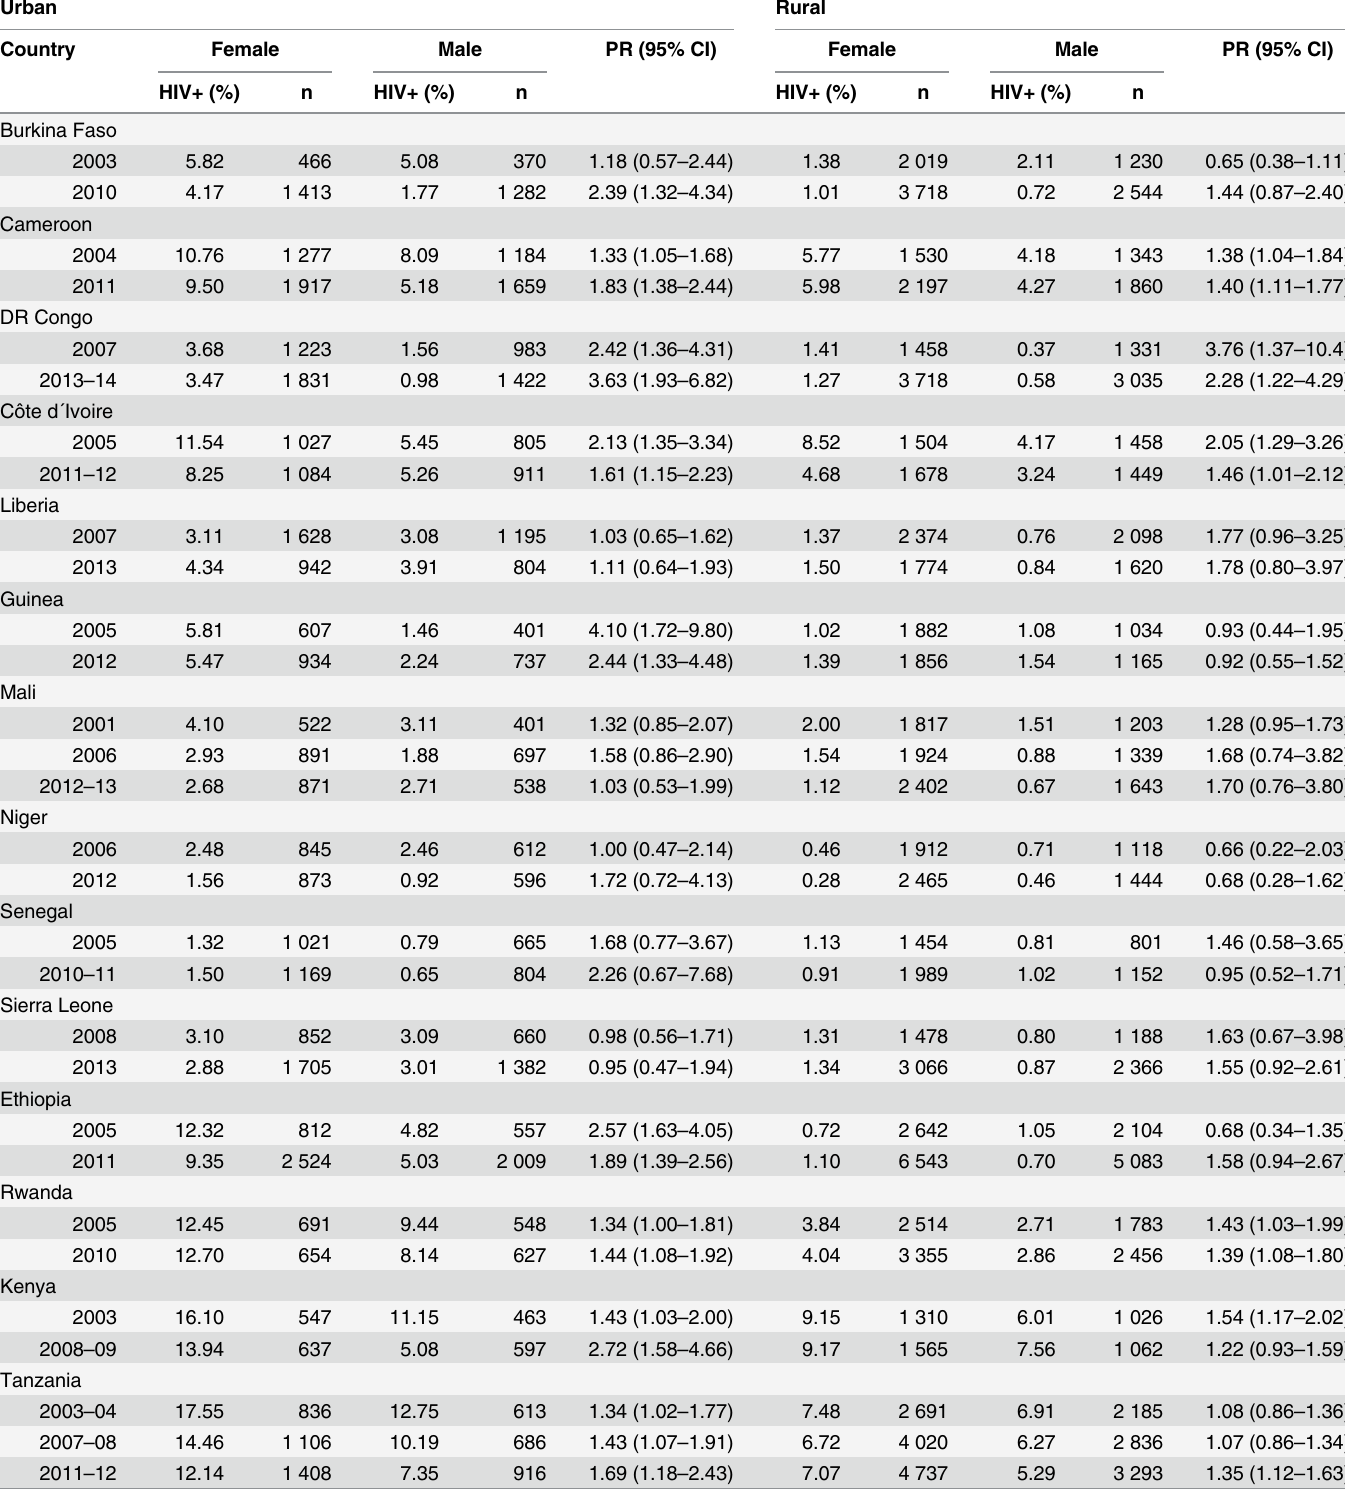
Table 2. Age-adjusted female: male HIV prevalence ratio (25 – 49 years) by country and urban/rural residence. Urban Rural